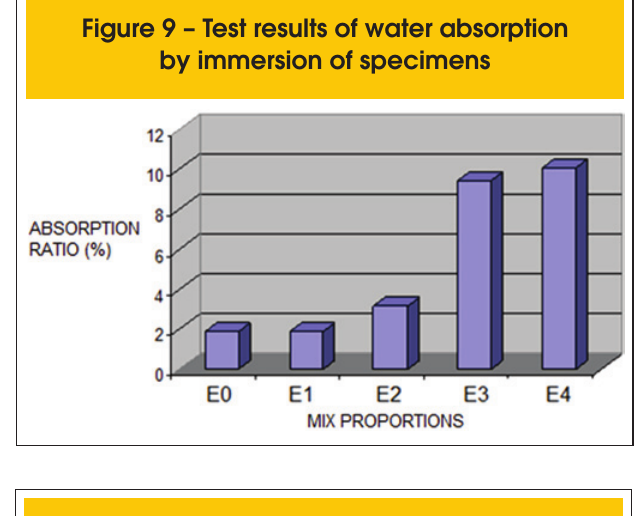
Figure 10 – Test results of water absorption of concrete blocks